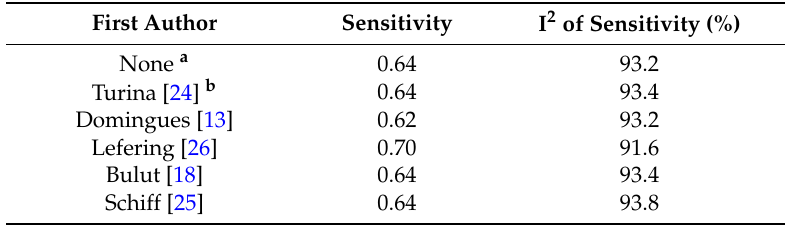
Table 5. Results of sensitivity analysis.